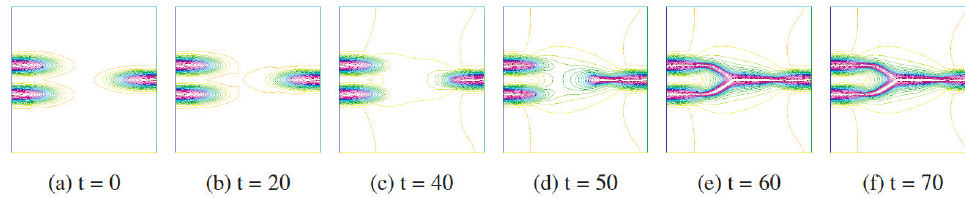
Figure A2. Time evolution of the phase-field variable z ( x , t ) (Case 2).